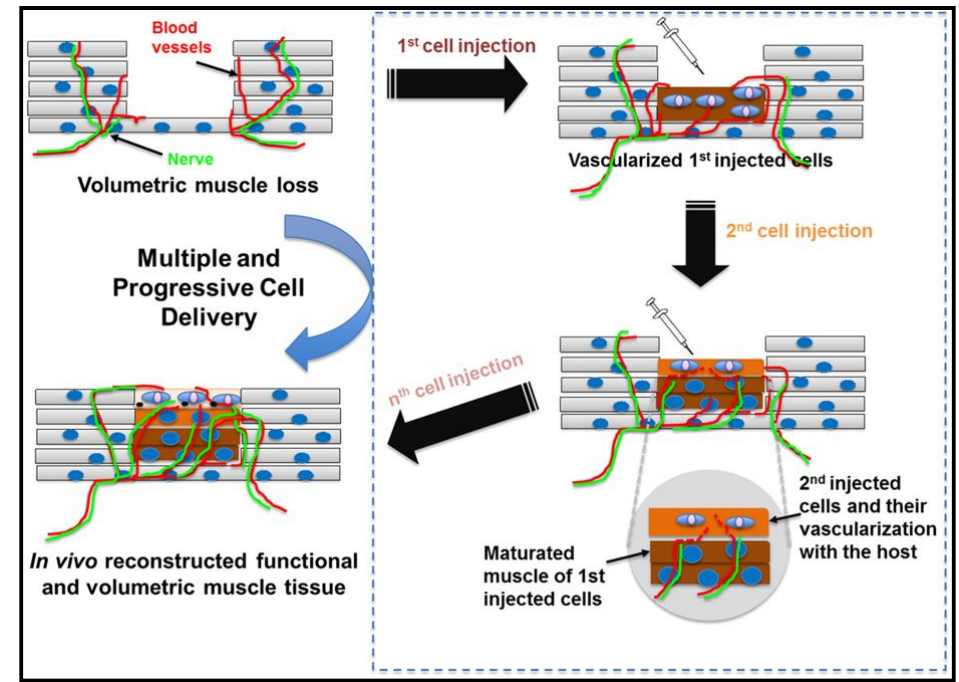
Figure 3. Schematic illustration of cell-based therapy for muscle cell delivery as a solution for volumetric muscle repair [4]. Reprinted by permission of springer Nature. Copyright © 2016 by Springer Nature.